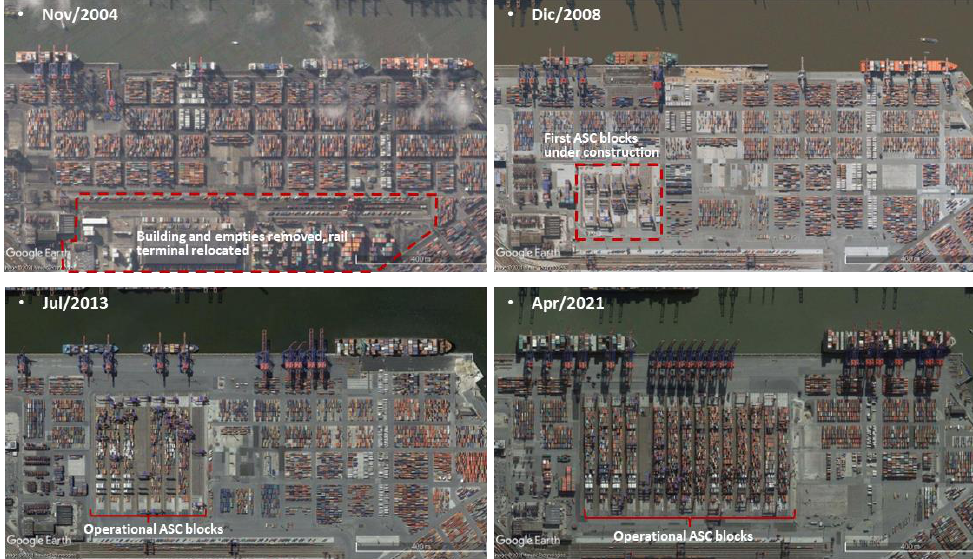
Figure 4. Phased implementation approach for new ASC stacks in the CTB terminal, Germany.